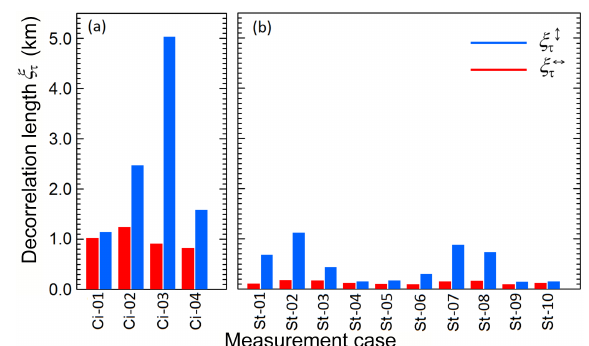
Figure 4. Decorrelation length calculated for the retrieved fields of τ from the (a) CARRIBA (Ci-01–Ci-04) and (b) VERDI (St-01– St-10) campaigns. Vertical arrows ( (cid:108) ) indicate the calculation of P 2 τ (L x ,L y ) and subsequent derivation of ξ τ along L y , horizontal arrows ( ↔ ) along L x